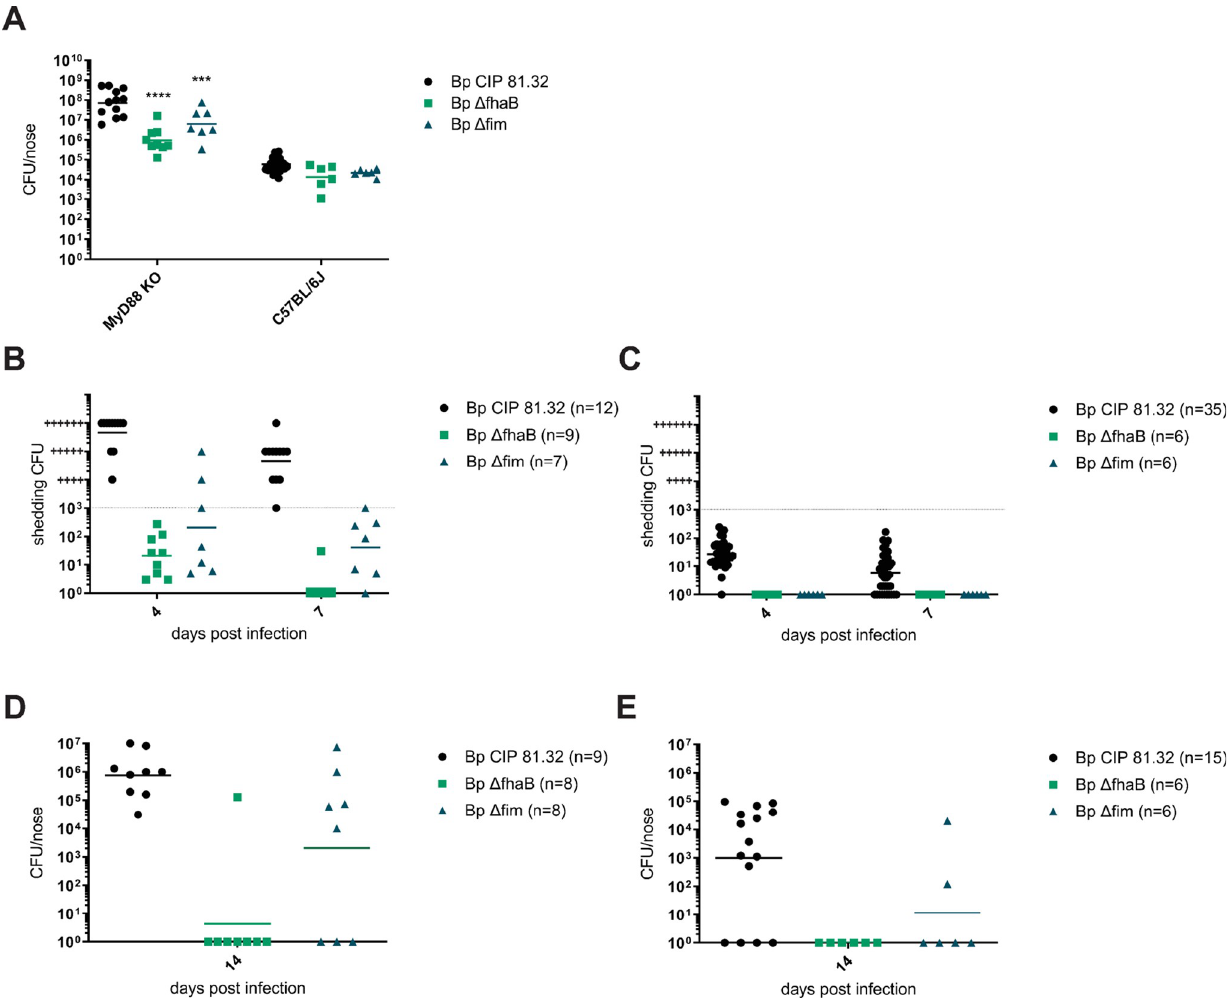
Fig 14. FhaB plays a key role in nasal cavity colonization and B . pertussis transmission. Nares of MyD88 KO and C57BL/6J mice were inoculated with 10 9 CFU of the WT or the indicated B . pertussis mutants ( Δ fhaB o r Δ fim) supended in 5 μ l. ( A ) Bacterial loads in the infected nasal cavities were determined on day 7 by plating of nose homogenates. Statistical significance of CFU count difference between mice inoculated with the wild-type B . pertussis and groups of mice infected by the mutant strains was assessed by one-way ANOVA followed by Dunnett’s multiple comparison test ��� (p < 0.001), ���� (p < 0.0001). ( B ) B . pertussis shedding from the nasal cavities of infected index MyD88 KO mice and ( C ) of index C57BL/6J mice was quantified on days 4 and 7 as described for Fig 4C. ( D ) Index MyD88 KO or ( E ) C57BL/6J mice inoculated into nares with 10 9 CFU of the indicated B . pertussis mutant were co-housed in the same cage in a 1:1 ratio with non-inoculated recipient MyD88 KO or C57BL/6J mice for 7 days before the index mice were withdrawn for determination of nasal shedding and nasal cavity bacterial loads (cf. B and C). The co-housed recipient mice were kept for another week prior to determination of bacterial loads in their nasal cavities on day 14. Dots represent bacterial counts in nasal cavities of individual recipient MyD88 KO ( D) and C57BL/6J ( E ) mice, respectively. Horizontal bars indicate the geometric means. The number of mice used per challenge strain is given in